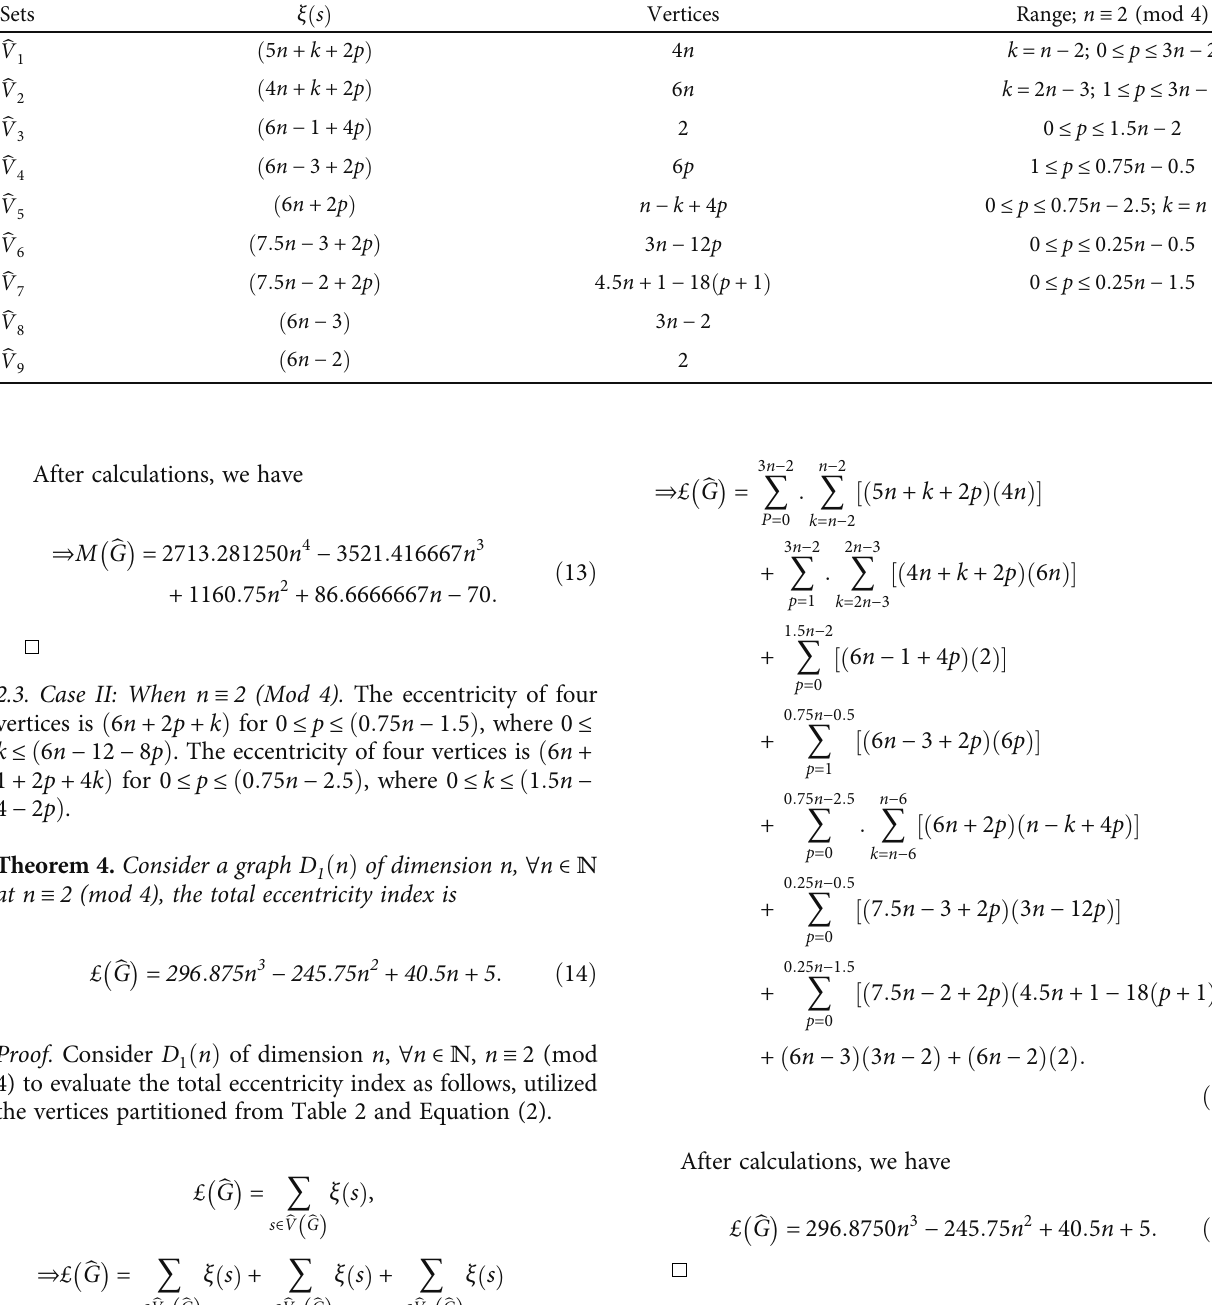
Table 2: Vertex partition of D